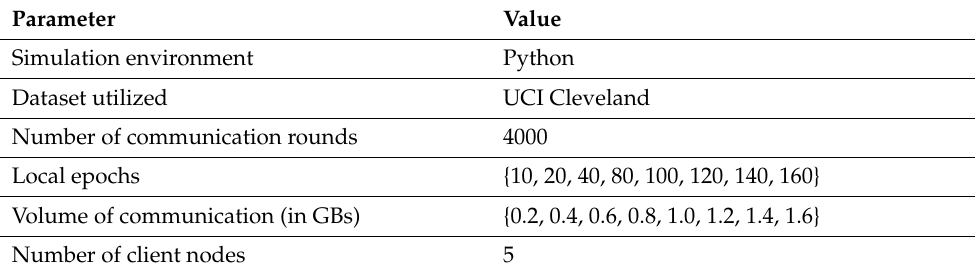
Table 3. Simulation parameters and settings.